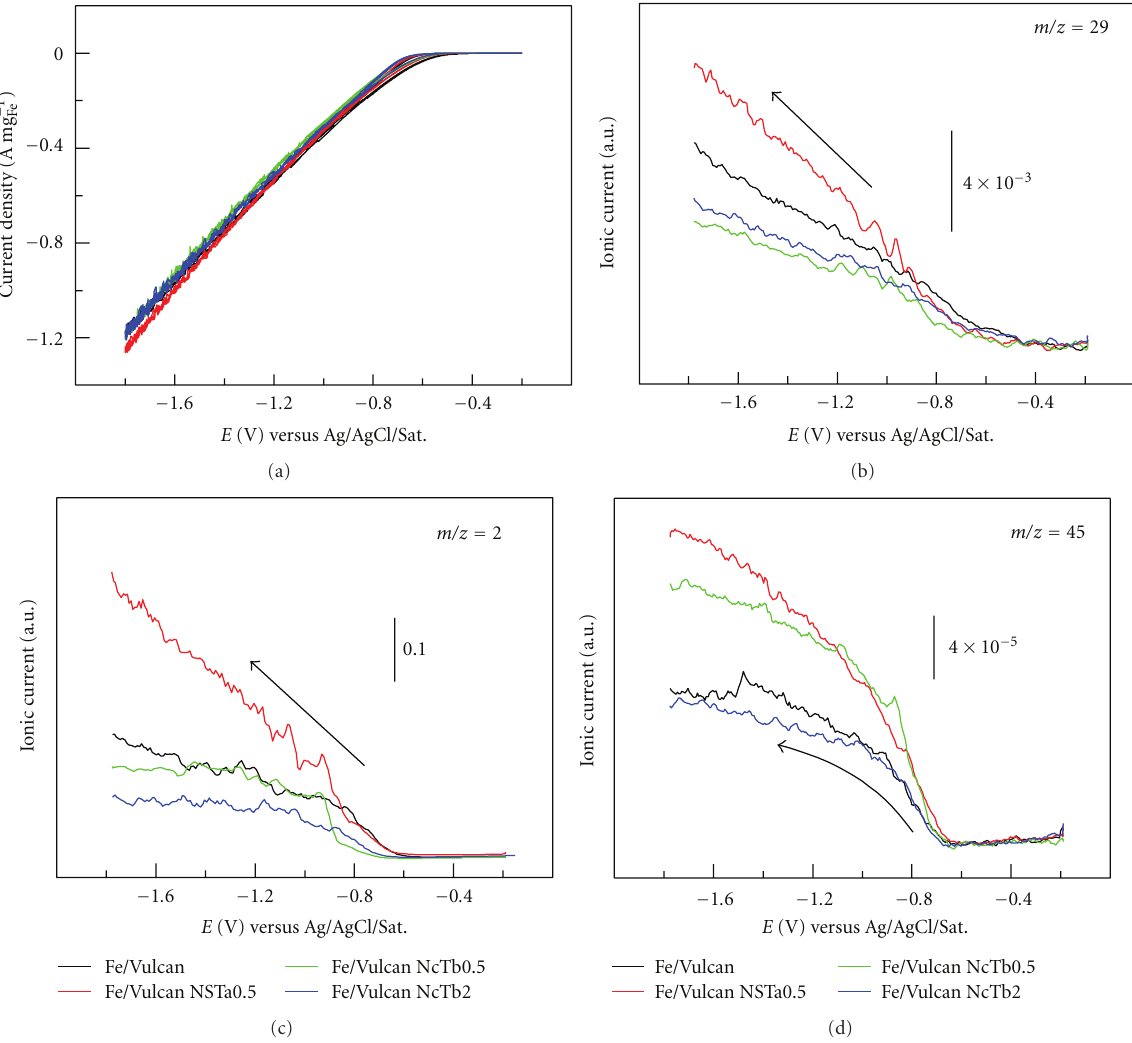
Figure 4: CVs and MSCVs for CO 2 -saturated solution in 0.5 M H 2 SO 4 on Fe/C catalysts (sweep rate 10mVs − 1 , E i = − 0 . 2 V versus